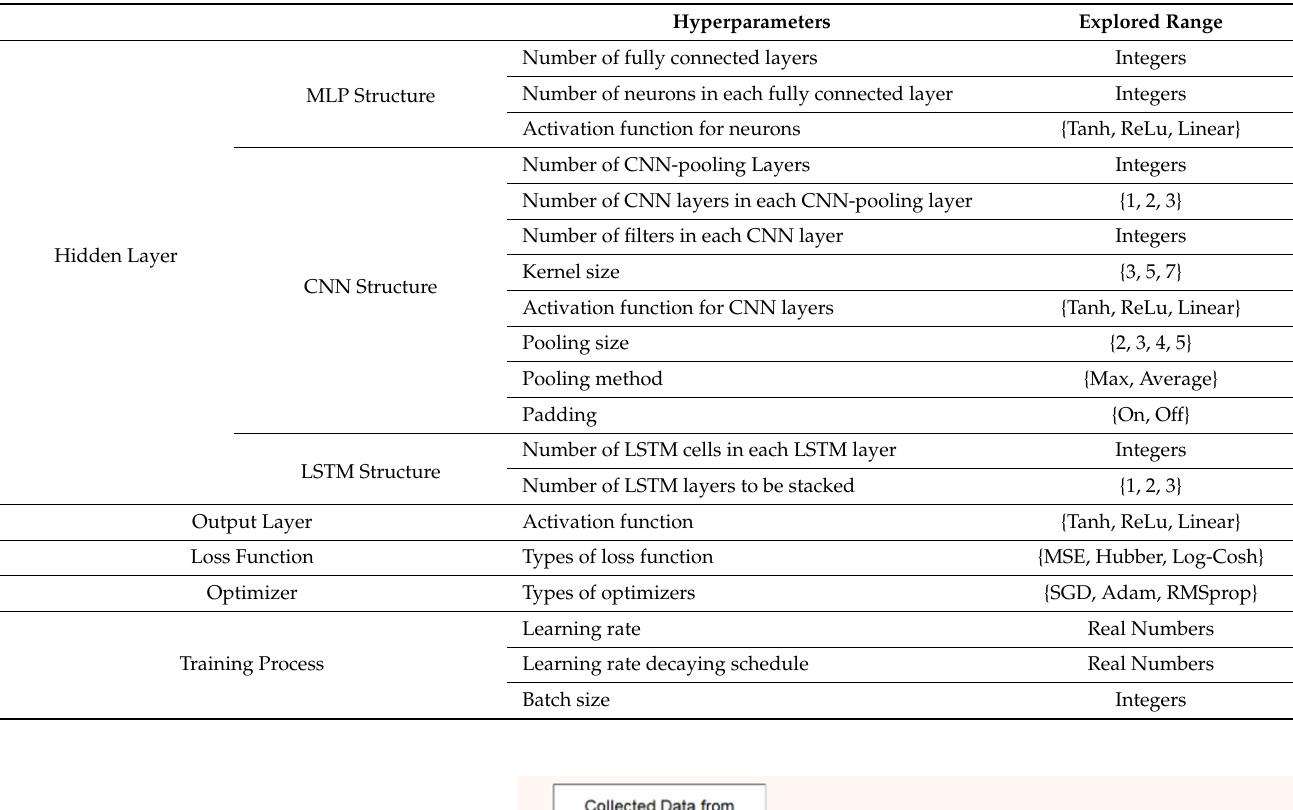
Table 1. Explored hyperparameters and their ranges.